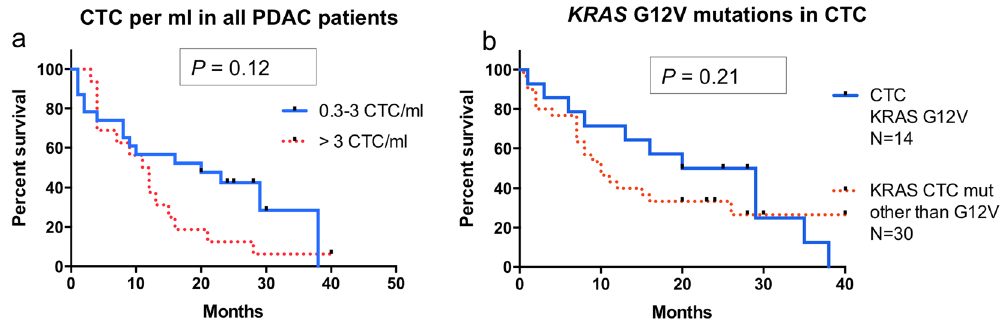
Figure 2. CTC and overall survival. ( a ) Survival analysis of PDAC patients with 0.3–3 CTC in the blood (blue, N = 23, MS 20 months) versus those with > 3 CTC/ml blood (red dots, N = 16, MS 11.5 months; P = 0.12). ( b ) Survival analysis of PDAC patients with CTC containing a KRAS G12V mutation (MS 24.5 months) and other KRAS mutations (MS 10 months; P = 0.21).